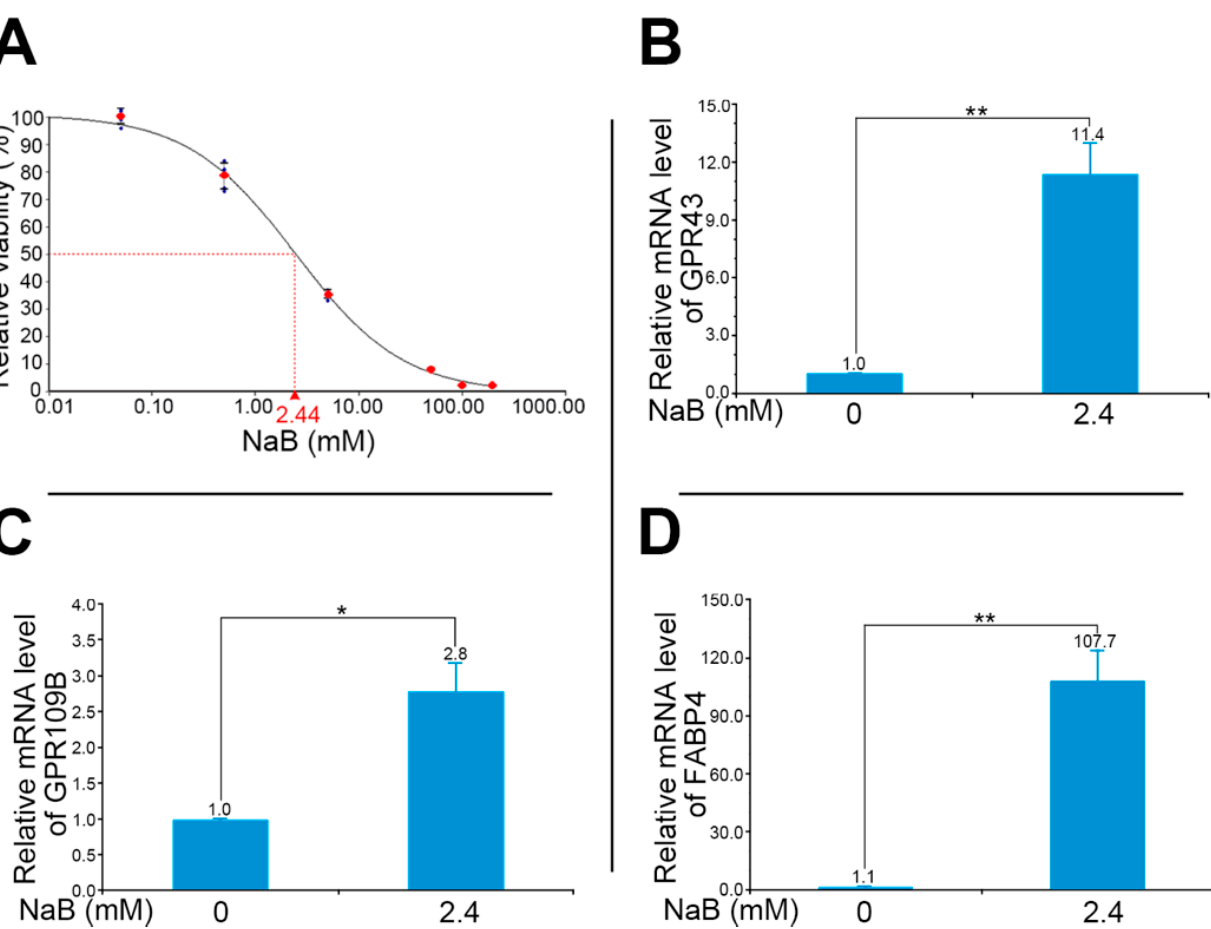
Figure 2. Up-regulation of SCFA-related genes in bladder urothelial cancer cells after NaB treatment. ( A ) The IC 50 value of about 2.4 mM NaB against HT1376 cells. ( B – D ) Relative mRNA levels of GPR43, GPR109B, and FABP4 in HT1376 cells. All mRNA levels were adjusted relative to the level of glyceraldehyde-3-phosphate dehydrogenase. Data are the mean ± SEM of at least two independent experiments. SCFA, short chain fatty acid; NaB, sodium butyrate. * p < 0.05 and ** p < 0.01.